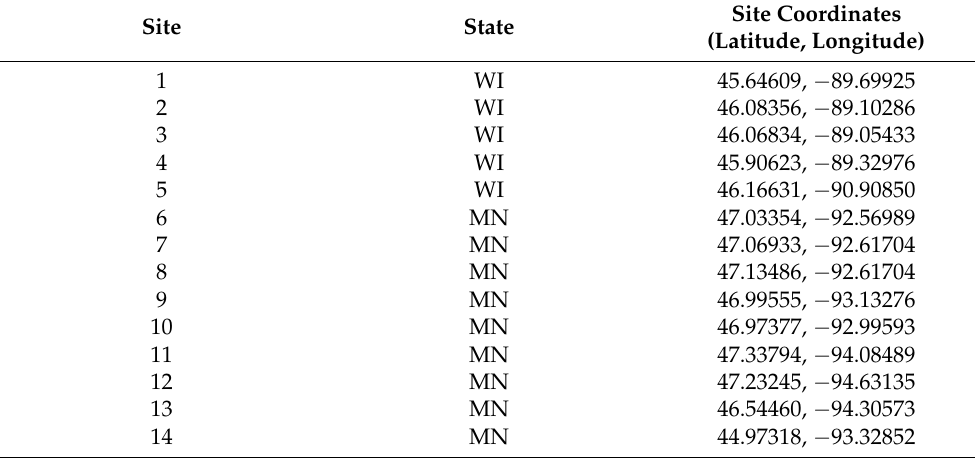
Table 1. The 14 locations from which phloem cores of Larix laricina (Du Roi) K Koch were sampled across Minnesota and Wisconsin on 15–16 July